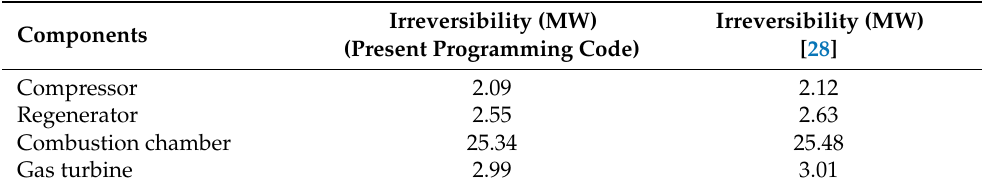
Table 6. Comparative results obtained between present programming code and Brayton cycle of the system studied in